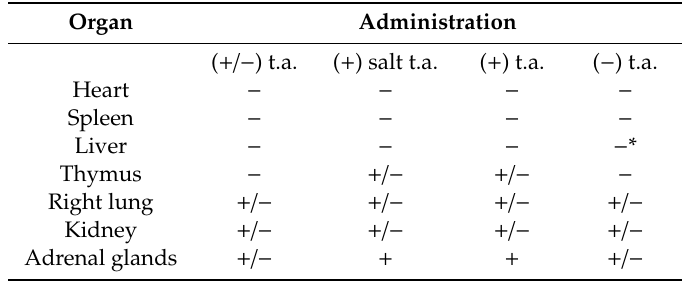
Figure A3. Subchronic toxicity by ( − ) oriented enantiomer treatment: organ histology. Effects of 15-day subchronic toxicity treatments with 360 µ mol / kg ( − ) thioctic acid on histological features of heart ( A ), lung ( B ), adrenal gland ( C ), thymus ( D ). Staining with hematoxylin–eosin techniques; 20 × magnification. Table A1. Organ mass variation following 15-day administration of ( +/ − ) thioctic acid, ( + ) salt thioctic acid, ( + ) thioctic acid, ( − )